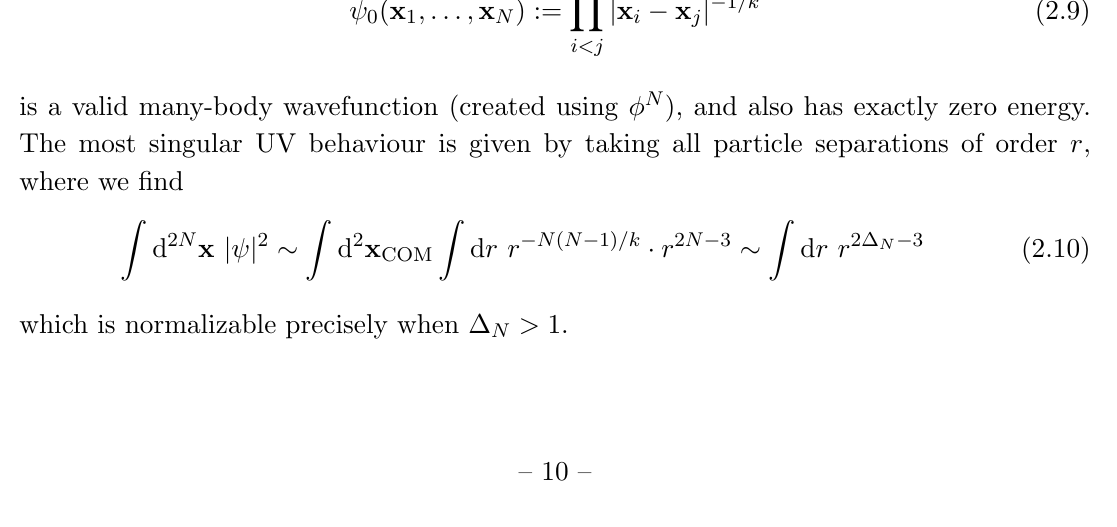
Figure 2 . The probability mass of the wavefunction scale a . The limit a 0 may be taken consistently for these states as they obey the unitarity → bound ∆ 1 and therefore have positive norm. Their wavefunction becomes a delta ≥